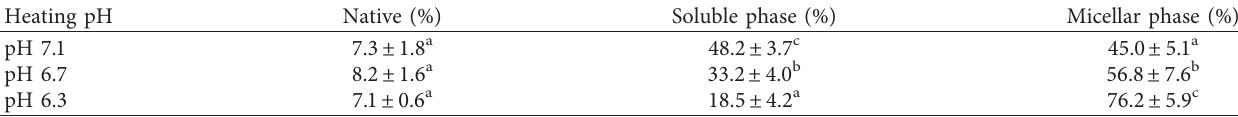
Table 1: The denaturation extent of β -lactoglobulin and its distribution.